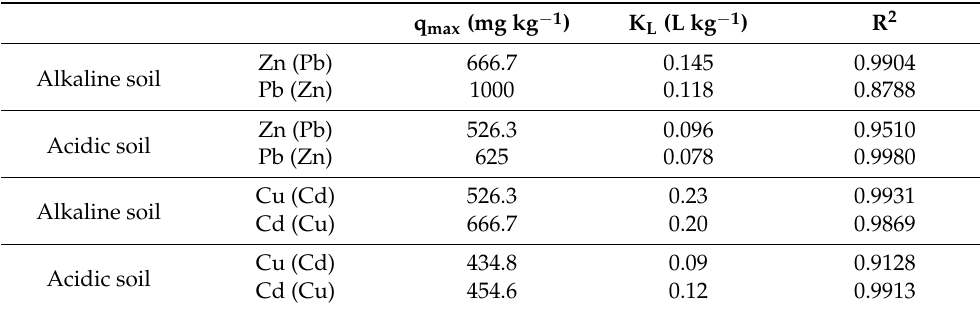
Table 3. Langmuir isotherm absorption parameters for Zn and Pb and for Cu and Cd during bimetallic systems of both studied